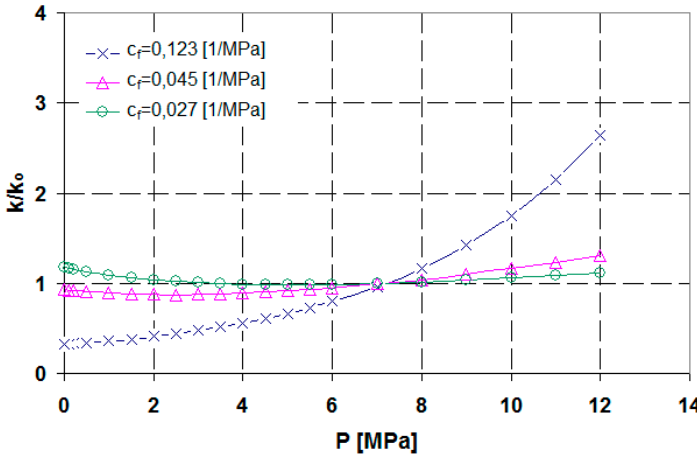
Figure 11. Changes in the Cretaceous Mesaverde Group coal permeability in relation to changes in the methane pressure based on the Cui and Bustin model [3].